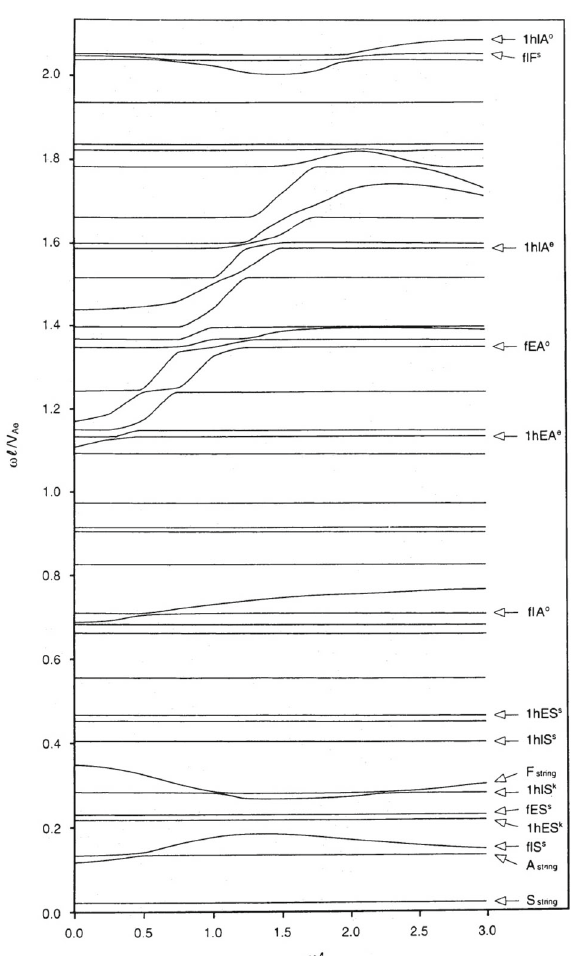
Fig. 40 Dispersion diagram of magnetoacoustic modes in the equilibrium structure of Fig. 39. Meaning of labels at the right of each curve: modes are identified as fundamental (f), first harmonic (1h), second harmonic (2h), …; string, internal or external (I or E); and fast, Alfvén or slow (F, A or S) according to the mode’s nature for κ (cid:11) 1. Here ω and κ are the frequency and the wavenumber modulus, while v Ae is the coronal Alfvén speed and (cid:13) is half the length of the supporting magnetic field. Parameter values used: